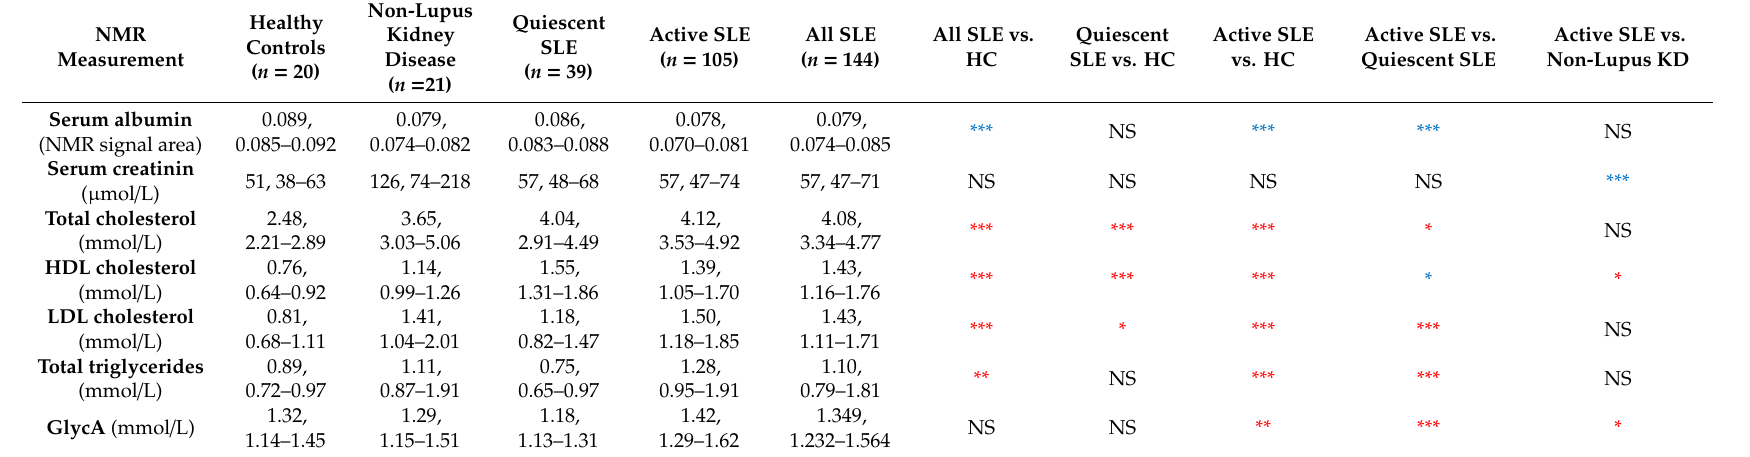
Table 1. Comparison of NMR results between controls and SLE